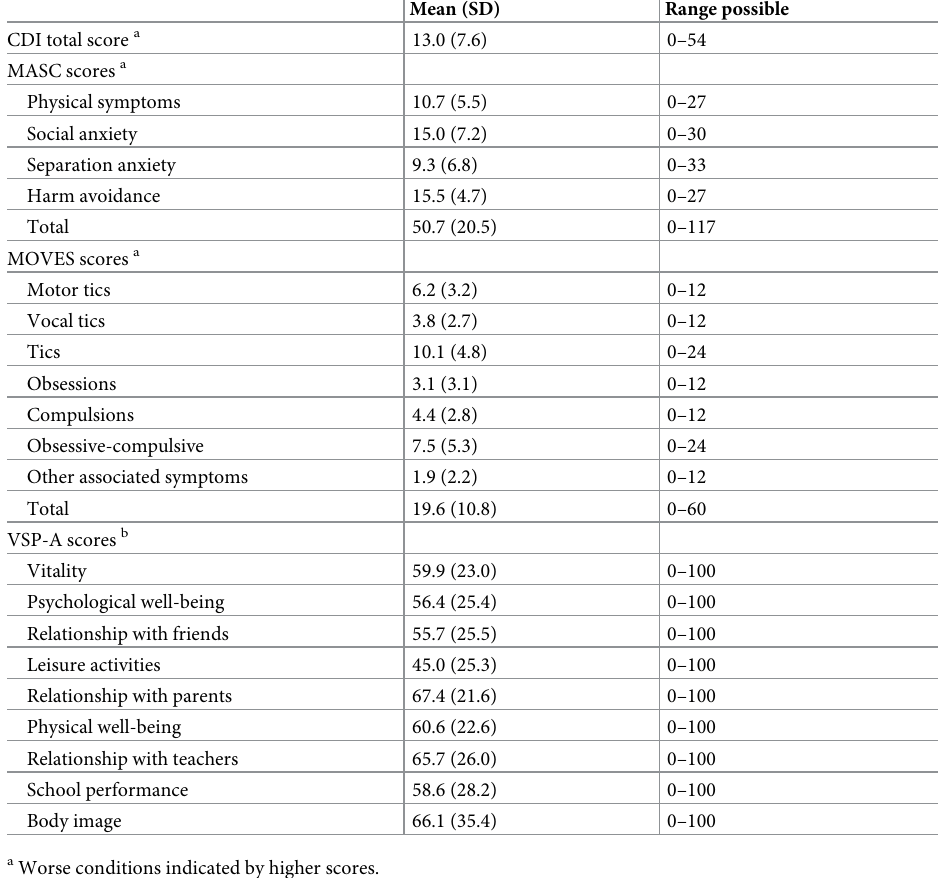
Table 2. Depression (CDI instrument), anxiety (MASC instrument), severity of tics (MOVES instrument) and health-related quality of life assessed by a generic instrument